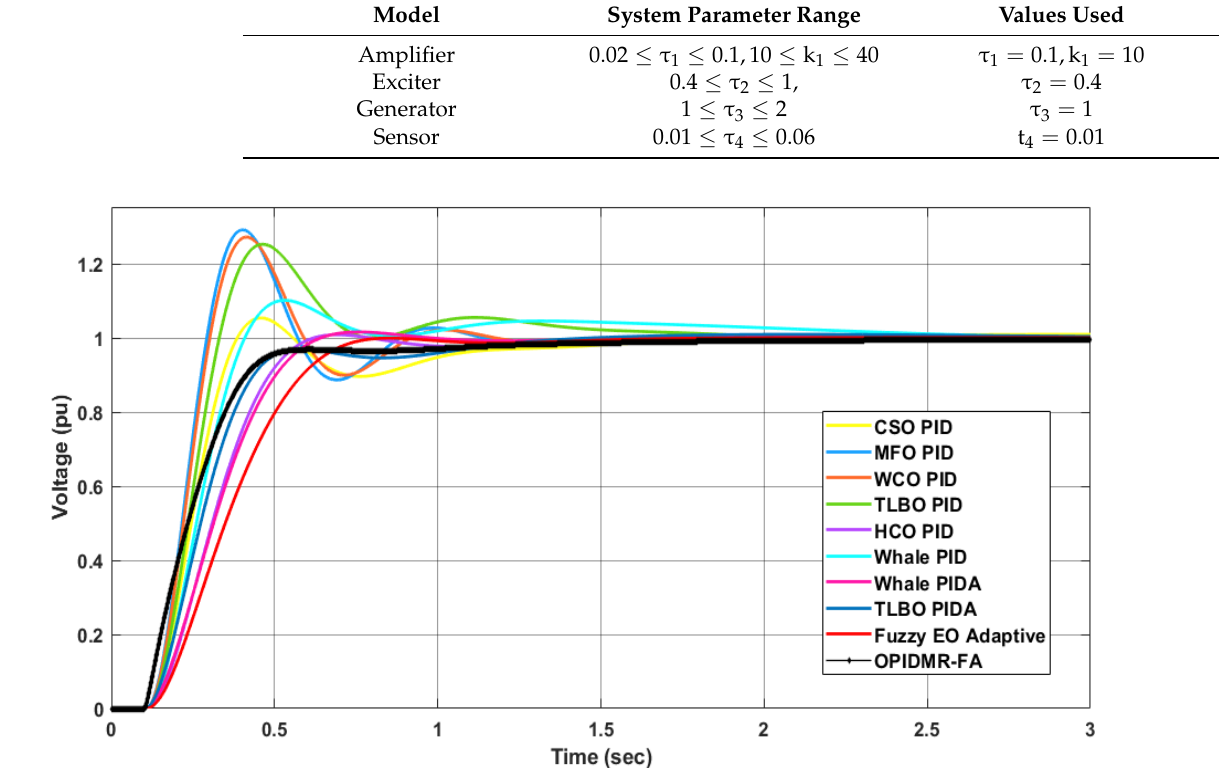
Figure 7. Step-change of 1 p.u. on the voltage reference of the AVR model.